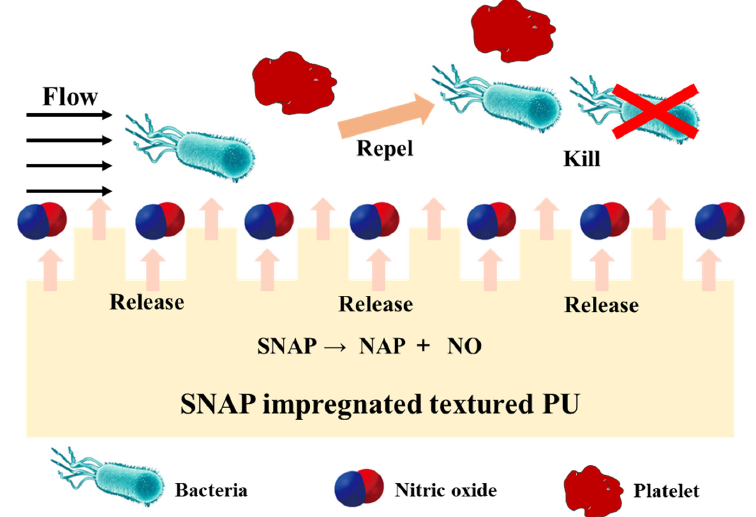
Figure 5. Schematic diagram of the biomimetic polyurethane (PU) biomaterials with NO-releasing property. Textured PU is impregnated with SNAP. NO releases from the surface texturing to mimic the inner surface of blood vessels, inhibiting platelets and bacterial adhesion. Reproduced with permission from [100], Acta Biomaterialia,